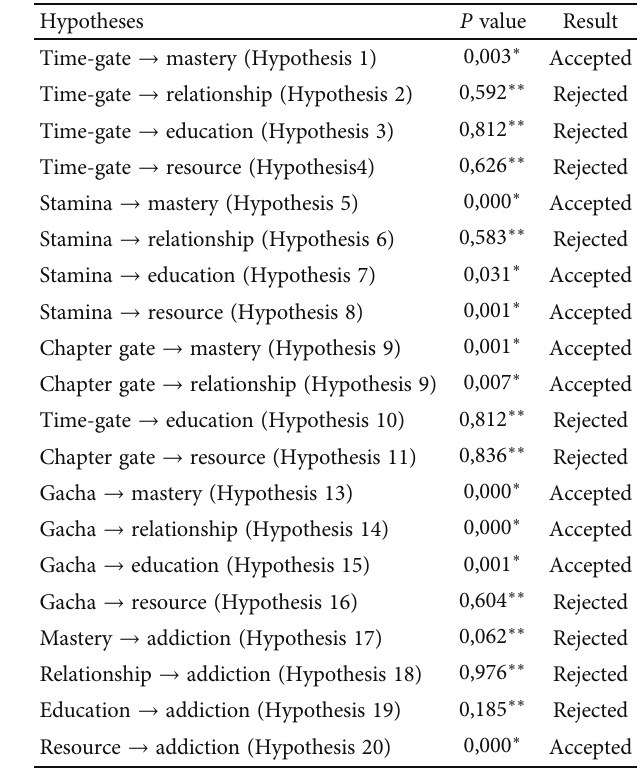
Table 5: Hypothesis testing.